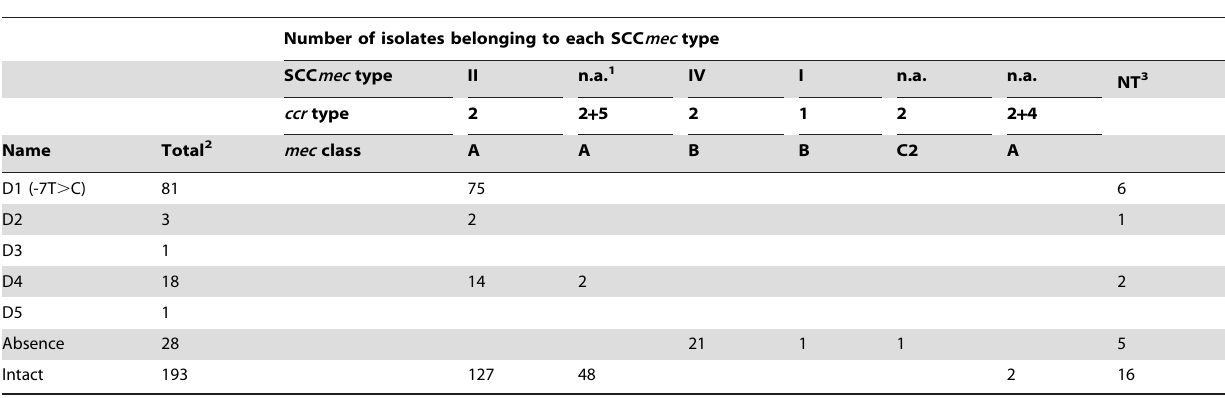
Figure 5. MRSA clinical isolates harboring a psm-mec mutation produce high amounts of PSM a 3. Nucleotide sequences of psm-mec genes of 325 MRSA isolates were determined ( Table 1 ). MRSA strains harboring intact psm-mec (Intact), -7T . C-mutated psm-mec (-7T . C), or no psm-mec (Absence) were cultured for 15 h. The amounts of PSM a 3 in the culture supernatants were measured. The vertical axis represents the relative amount of PSM a 3 against that of Newman strain. Closed circles represent the amounts of PSM a 3 of each MRSA strains, which are the means from two independent experiments. Magenta lines represent the averaged amount of PSM a 3 of each MRSA groups. Cyan dotted line represents the amount of PSM a 3 of CA-MRSA strain FRP3757 (USA300). Student t-test P-values are presented. ND, not detected. doi:10.1371/journal.ppat.1003269.g005 Table 2. Typing of SCC mec of MRSA clinical